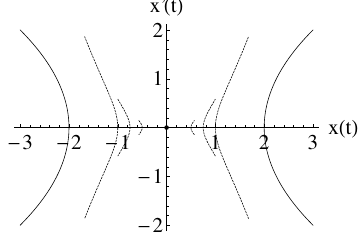
Figure 2. The phase plane of monotone subsequences for problem